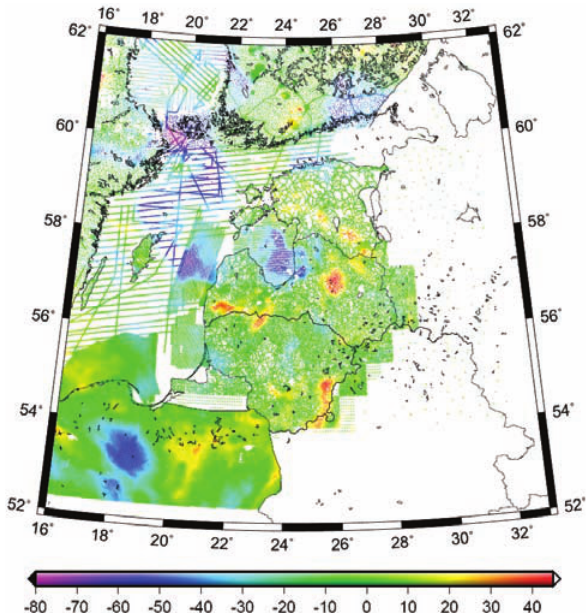
Fig. 1. Distribution of gravity data points. Free-air anomaly ∆ g values range from –84 to +44 mGal, with a mean of –9.5 mGal. The STD of the anomaly values is 18 mGal. The colors of the dots are proportional to the range of the anomaly, cf. the